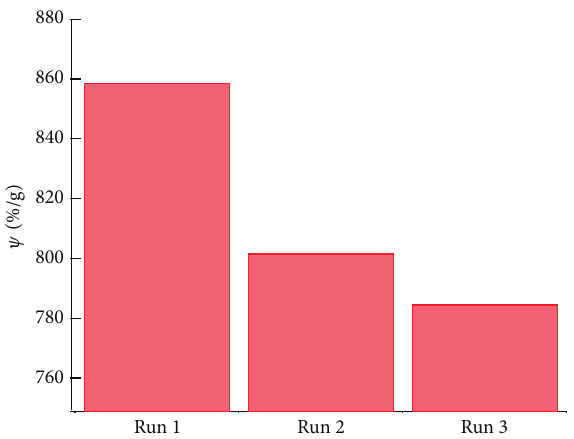
Figure 10: Cycling degradation curve for CdS-TiO 2 with 0.2 Cd:Ti molar ratio.